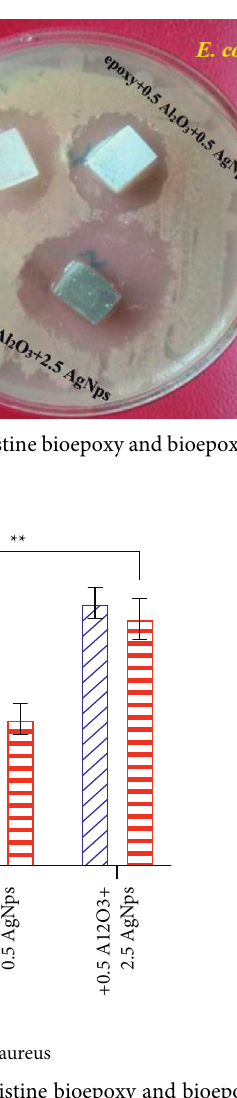
Figure 6: Antibacterial activity of pristine bioepoxy and bioepoxy reinforced by various weight fractions of Al 2 O 3 -AgNps against E. coli and S. aureus . Asterisks indicate that results significantly different to the unmodified control ( ∗∗ p < 0 .